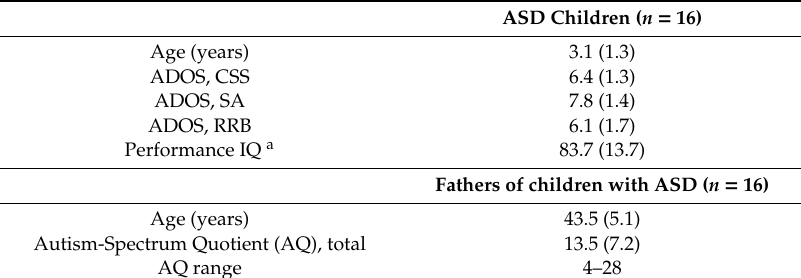
Table 1. Demographic and clinical characteristics of the